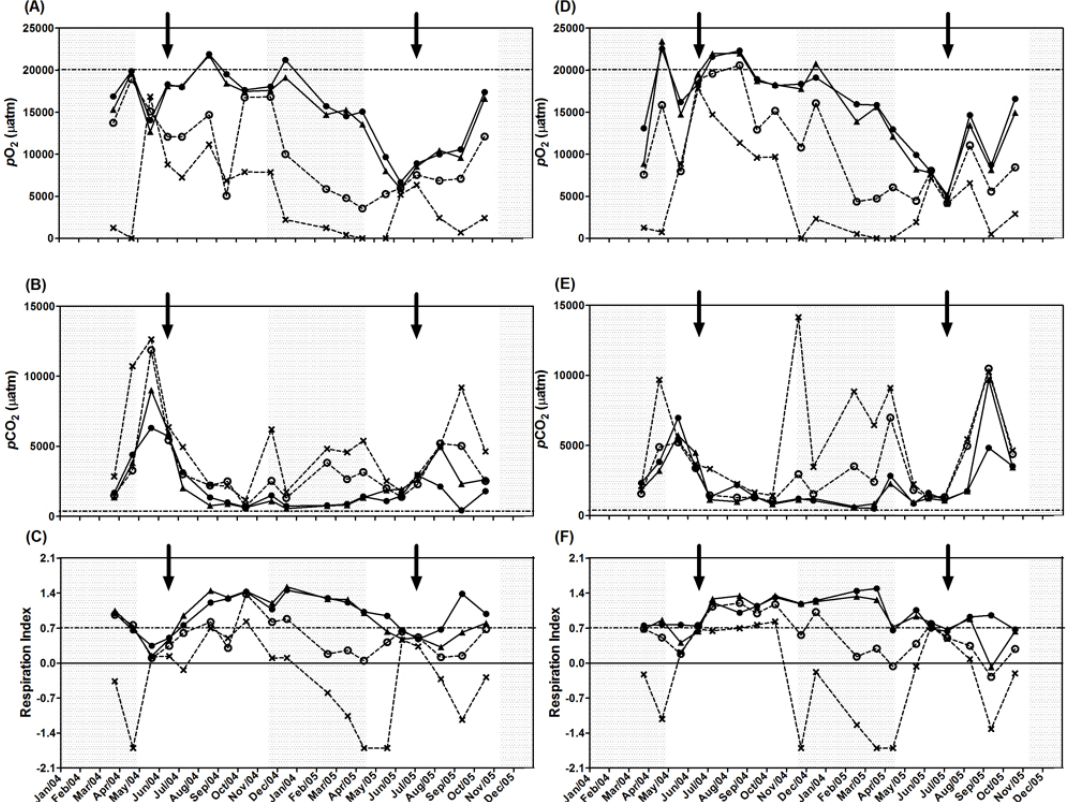
Fig. 3. Monthly fluctuations in p O 2 ( A and D ), p CO 2 ( B and E ) and respiration index ( C and F ) in Lake Barra and Lake Aguap´e, respectively, during 19 months from March 2004 to October 2005. Symbols, arrows and the dotted frame are as defined in Fig. 2. The dashed-dotted line represents the p O 2 ( A and D ) or p CO 2 ( B and E ) in equilibrium with the atmosphere and the critical limit for RI ( C and F ) to major aquatic organisms (Brewer and Peltzer, 2009). Negative values of RI indicate a ratio p O 2 : p CO 2 <